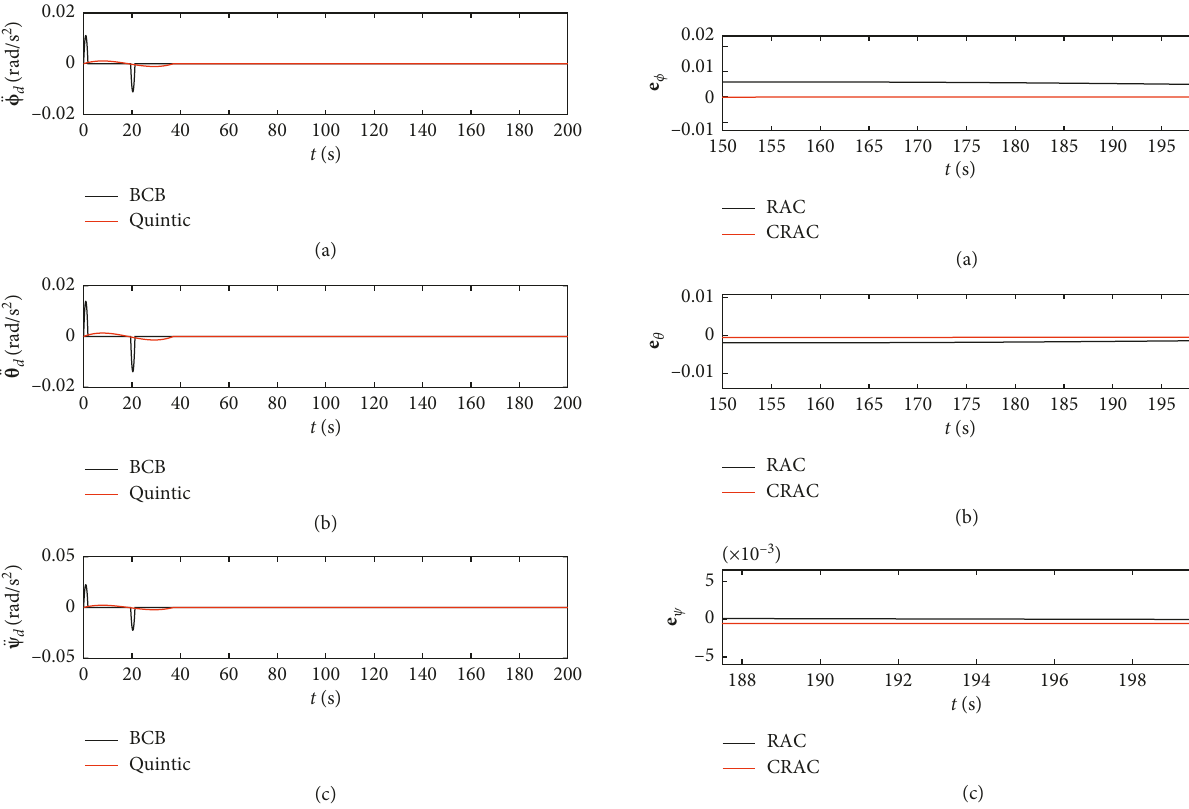
Figure 6: Enlarged version of Figure